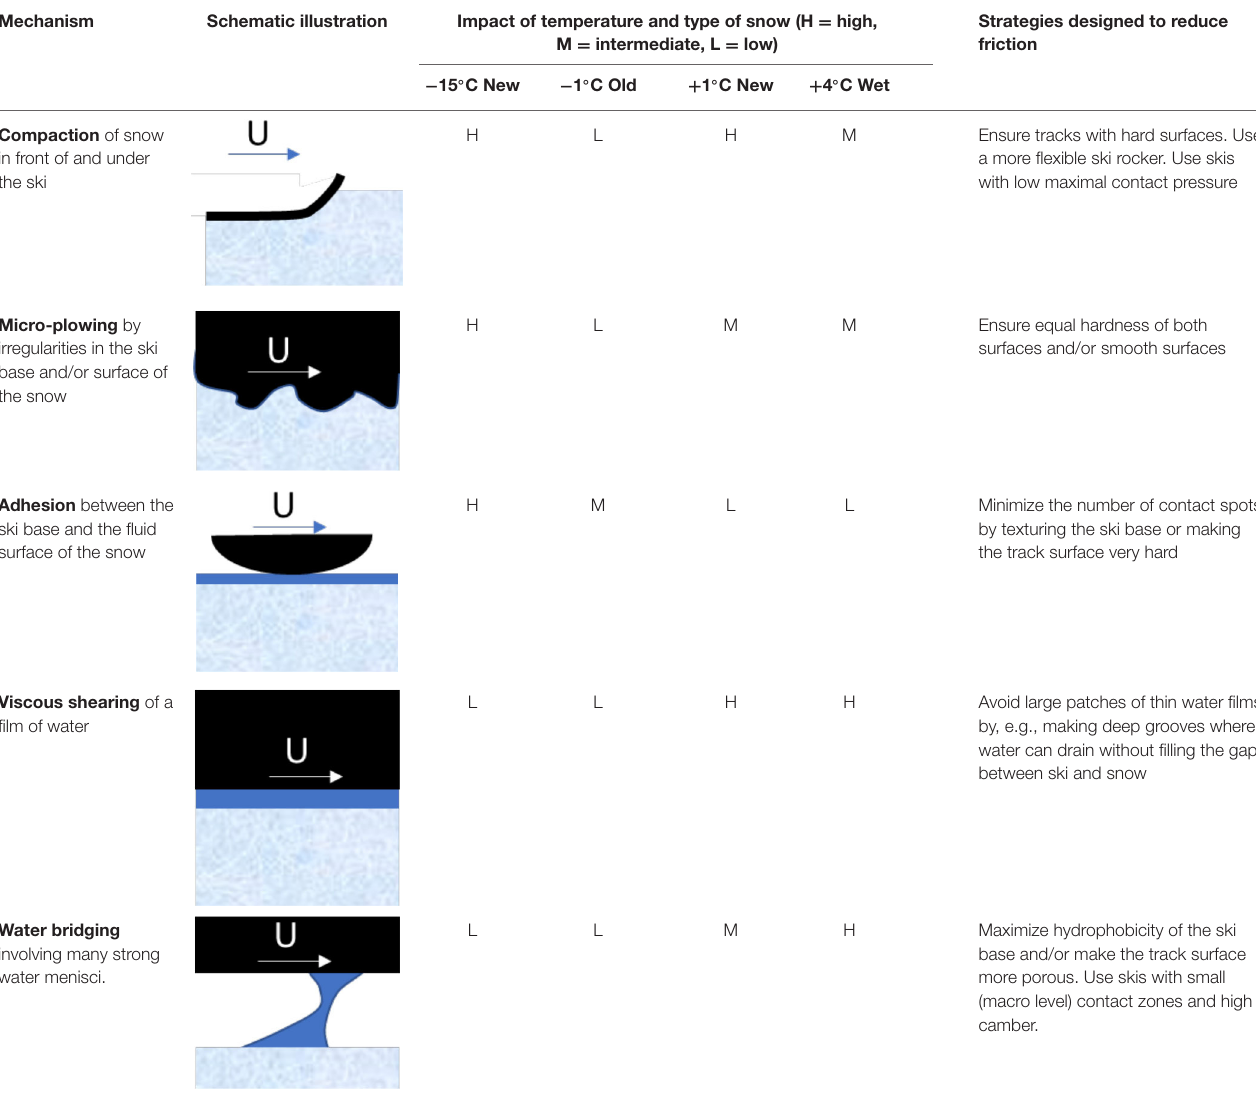
TABLE 1 | Mechanisms that lead to and strategies for reducing friction.